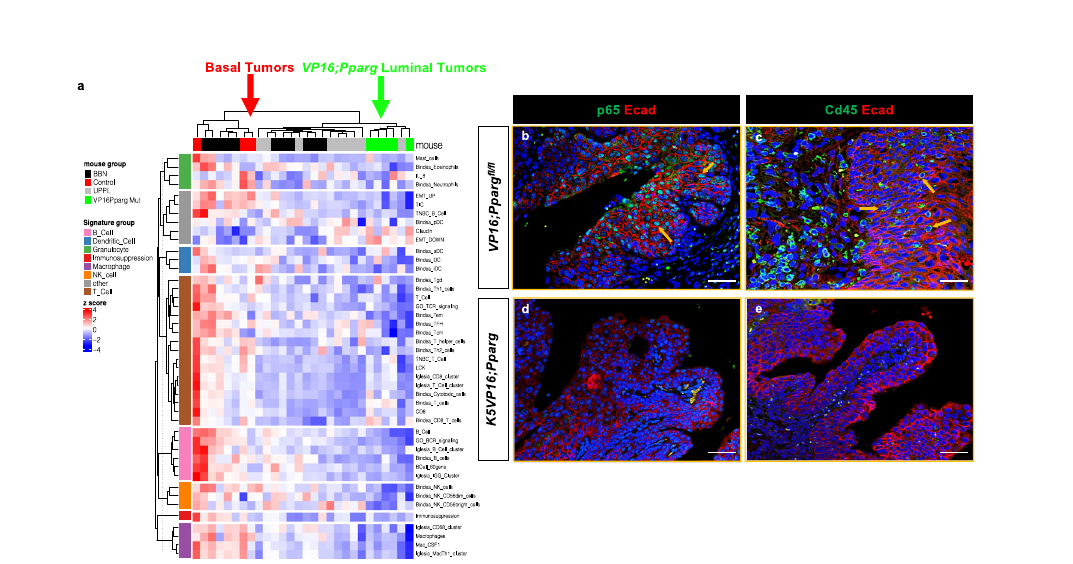
Fig. 3 Activation of Pparg in K5VP16;Pparg mice produces luminal bladder tumors. a Schematic showing time-course of tamoxifen and BBN treatment used in experiments with K5VP16;Pparg mice and controls. b – g Ultrasound images of VP16;Pparg fl / fl control bladders ( b ) and a K5VP16;Pparg mutant ( c ) 4 months after Tamoxifen induction. Yellow arrow in c denotes a lesion protruding into the lumen. H&E images of bladders from a VP16;Pparg fl / fl control ( d ) and a K5VP16;Pparg mutant ( e ) 4 months after Tamoxifen induction. Double black arrows in ( e ) denote high grade papillary lesions. Expression of E- cadherin, smooth muscle actin, and laminin in a VP16;Pparg fl / fl control ( f ) and in a K5VP16;Pparg mutant ( g ). h – w An H&E image of human luminal tumor ( h ), a K5VP16;Pparg mutant tumor ( l ), a human basal tumor ( p ), and a VP16;Pparg control basal tumor ( t ). Expression of Krt14, P63, and Krt6a in a human luminal tumor ( i ), a K5VP16;Pparg mutant tumor ( m ), a human basal tumor ( q ), and a VP16;Pparg control basal tumor ( u ). Krt20 and Pparg expression in a luminal tumor ( j ), a K5VP16;Pparg mutant tumor ( n ), a human basal tumor ( r ), and a VP16;Pparg control basal tumor ( v ). Ki67 and Foxa1 expression in a luminal tumor ( k ), a K5VP16;Pparg mutant tumor ( o ), a human basal tumor ( s ), and a VP16;Pparg control basal tumor ( w ). x Quanti fi cation of the percentage of luminal tumors observed in VP16;Pparg controls ( n = 10) and K5VP16;Pparg mutants ( n = 10). Box plots display minima, maxima, and interquartile range (IQR). Signi fi cance was calculated by a one-sided Mann – Whitney U test. **** p = 3.14e-05. y Upregulated and downregulated signaling pathways based on RNA-seq analyses of K5VP16;Pparg mutant tumors compared to VP16;Pparg fl / fl basal control tumors 4 months after tamoxifen induction. p values were calculated by hypergeometric test and corrected for multiple testing. Scale bars in d – e 200 μ m. Scale bars in f – w , 100 μ m. Source data are provided as a Source Data fi le.